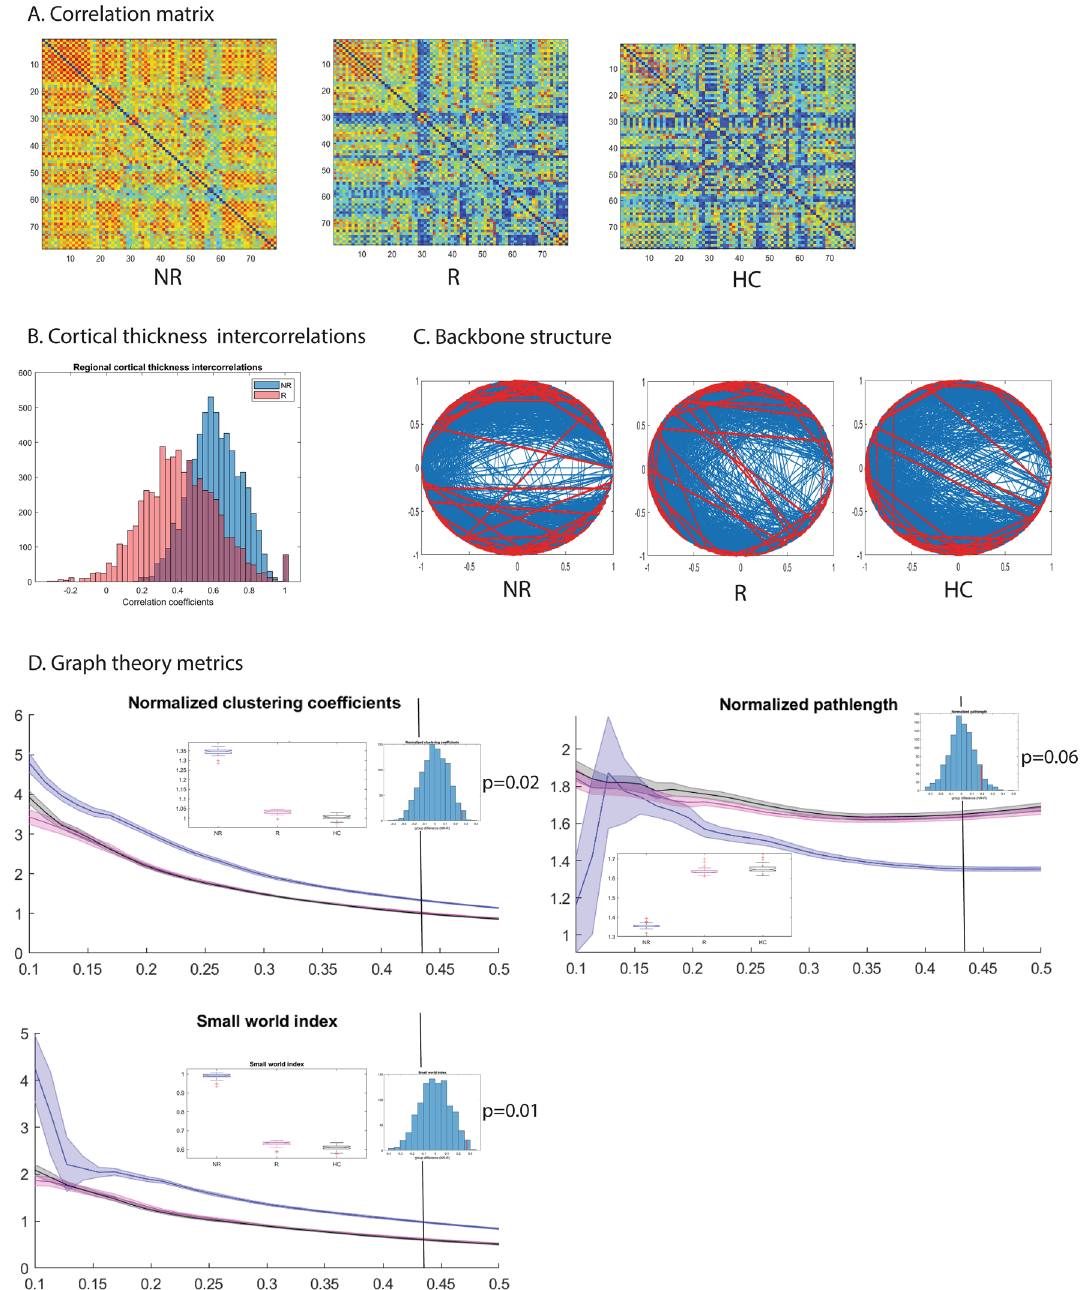
Figure 2. Cortical thickness covariance patterns in placebo responders and non-responders: graph theoretical analysis. ( A ) Correlation matrices of cortical thickness values across 78 cortical areas delineated using Automated Anatomical Labeling (AAL) in placebo non-responders (NR), placebo responders (R), and a group of healthy age- and sex-matched controls (HC). ( B ) A histogram depicting distributions of correlation coefficients in placebo responders and non-responders. ( C ) Backbone structure for correlation matrices in A at the sparsity threshold of 0.43. ( D ) Graph theoretical characteristics of these matrices across the range of sparsity thresholds from 0.1 to 0.5. Error ribbons represent standard deviation for parameter estimates from leave-one- out cross-validation. Box plots represent group comparisons at the sparsity threshold of 0.43 based on leave- one-out cross-validations; histograms represent the p-values based on permutation tests at the sparsity threshold of